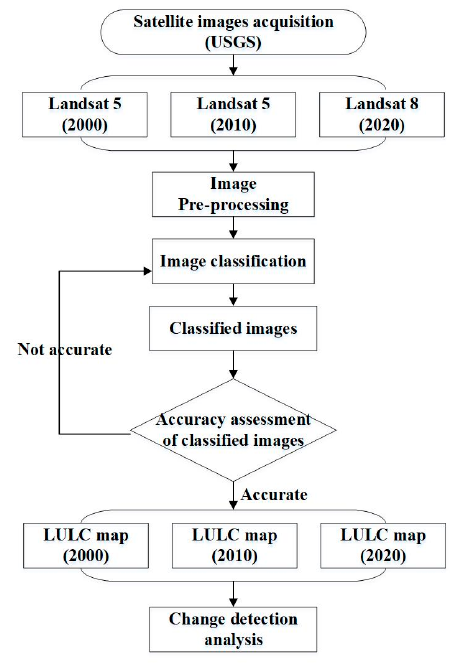
Figure 4. Detailed flow chart of methodology.